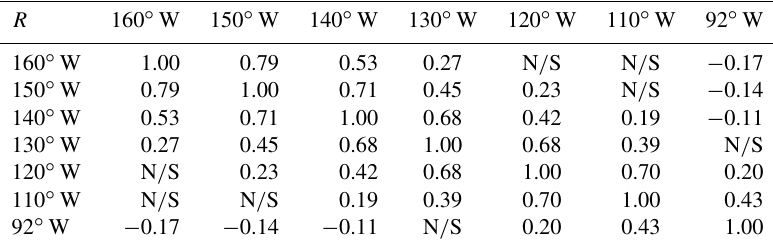
Figure 8. Diagnostics of upwelling in the north Peruvian upwelling system, spanning the latitude range 5–10 ◦ S: (a) equatorward wind stress (Nm − 2 ): (b) Ekman flux (Sv); (c) upwelling flux (Sv). Climatologies are obtained by averaging across the 1988–2007 time series. Table 2. Correlation coefficient ( R ) matrix at zero lag for the EUC transport at the selected longitudes, for R values with p values < 0 . 01 (99% confidence interval). Non-significant R values are indicated as N /